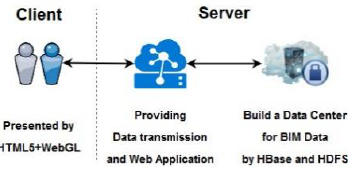
Figure 2. System for data storage and 3D viewing of massive BIMs (Chen et al., 2016)